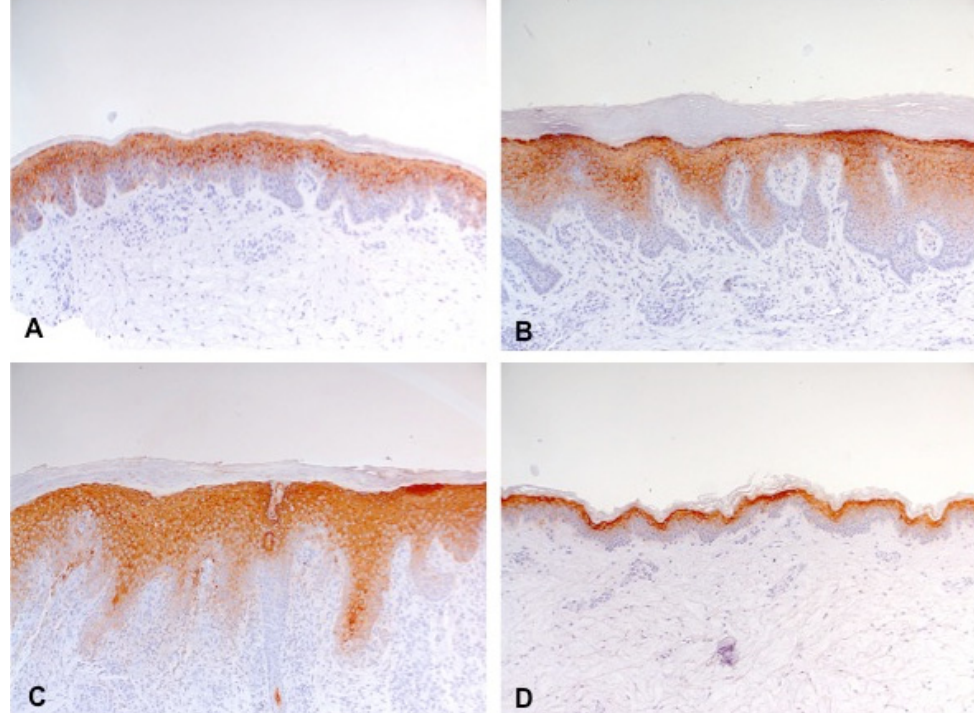
Figure 6. Increased expression of involucrin (extension and thickening of the brown staining line) in lesional skin of classic atopic dermatitis ( A ), atopic prurigo ( B ), and non-atopic prurigo nodularis ( C ) compared with healthy controls ( D ) shown by immunohistochemistry (100-fold magnification).